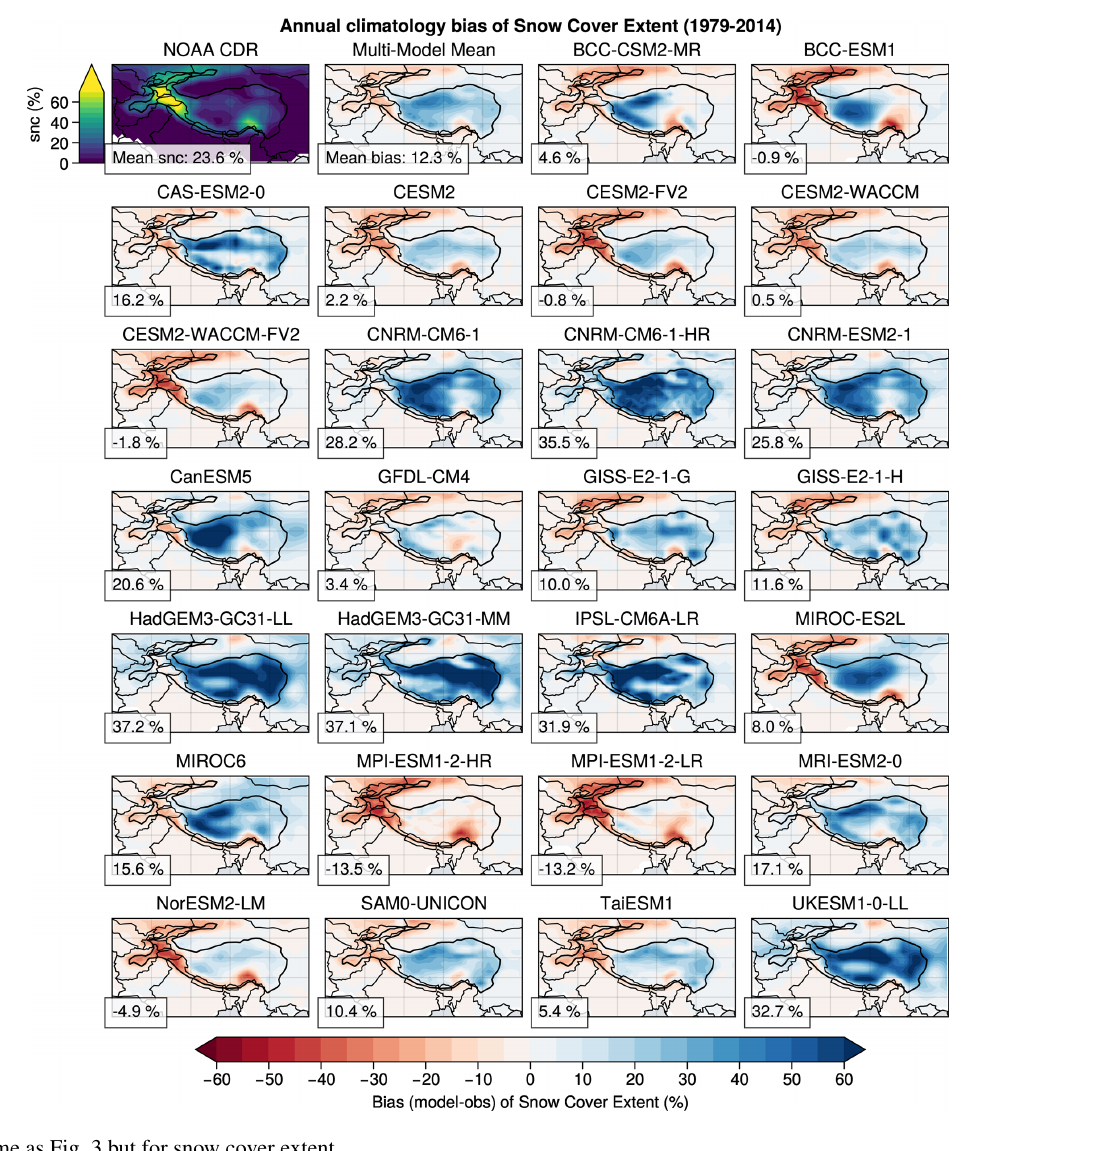
Figure B1. Same as Fig. 3 but for snow cover